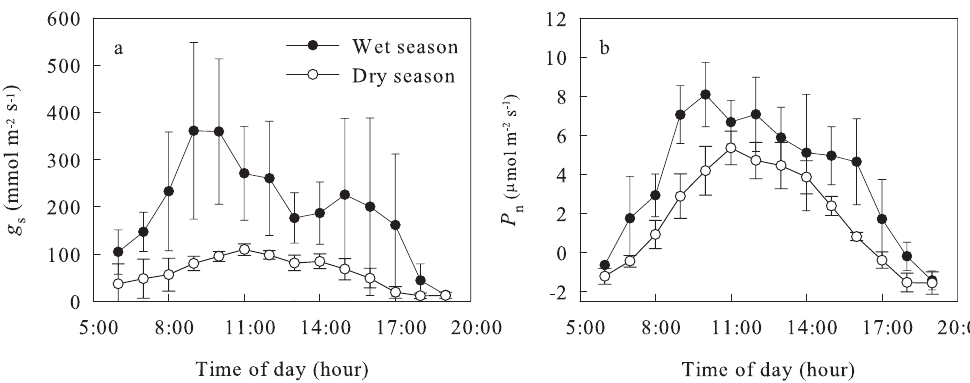
Fig. 4. Diurnal patterns of leaf stomatal conductance ( g s ) and net photosynthesis ( P n ) of A. mangium in both the wet season (9 and 10 May, 26 July, 1 August) and the dry season (6 and 7 November, 6 and 17 December). Error bars indicate standard deviation ( n = 4). July and December are representative of wet and dry conditions, respectively. Data were obtained by leaf gas exchange measurements.